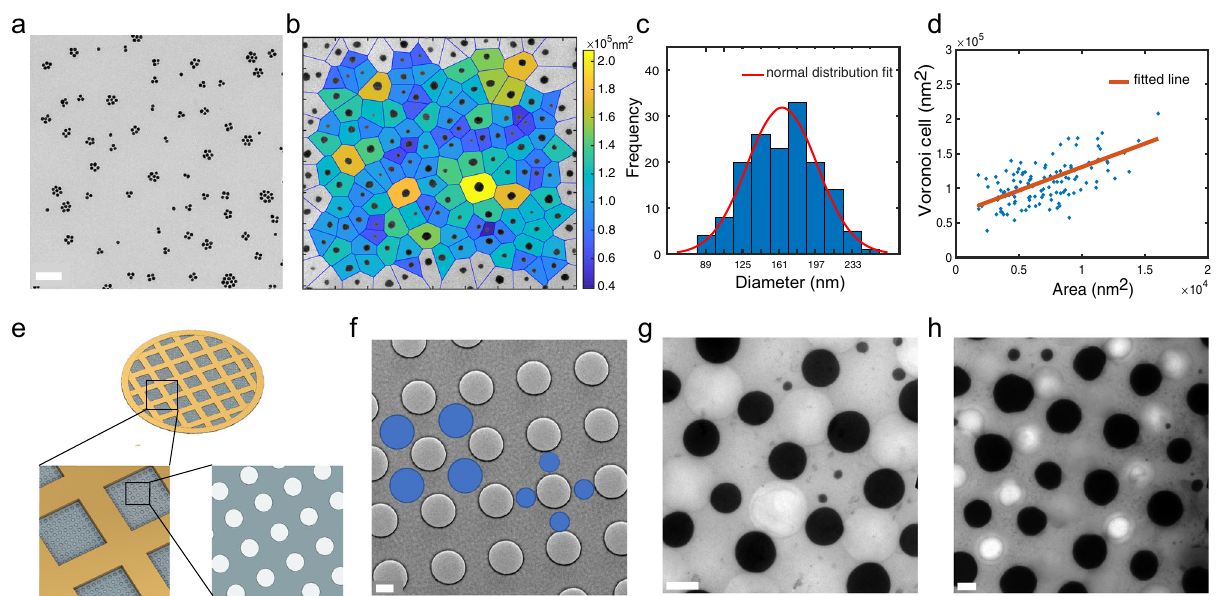
Fig. 4 Controlled PGNP crystallization on substrates. a PGNP clusters assembled from 25 nm Au NPs (PS = 6k) with PP/PE at + PP = PE ~ 0 : 05 % . Scale bar is 200 nm. b TEM image of (1.7k) Au-PS 0.70 NP crystals formed with PP/PE at + PP = PE ~ 0 : 08 % and Voronoi representation color coded by the Voronoi cell area in 2D. c Crystal size distribution plot, fi tted with a normal distribution curve. d Voronoi cell area vs. crystal size in 2D, fi tted with a linear curve. (1.7k) Au-PS 0.70 NP crystals characterized in c and d were formed with PP/PE at + PP = PE ~ 0 : 08 % . e Schematic illustration of the templated carbon fi lms with orthogonally arrayed holes mounted on TEM grids. Two possible nucleation sites are highlighted with blue circles in f . g (1.7k) Au-PS 0.70 NP crystals formed at bridge sites between adjacent holes. h (1.7k) Au-PS 0.70 NP crystals formed at center sites of the hole lattice. PP/PE was added at + (cid:2) 0 : 15 % . Scale bars are 500 nm in f – h PP = PE